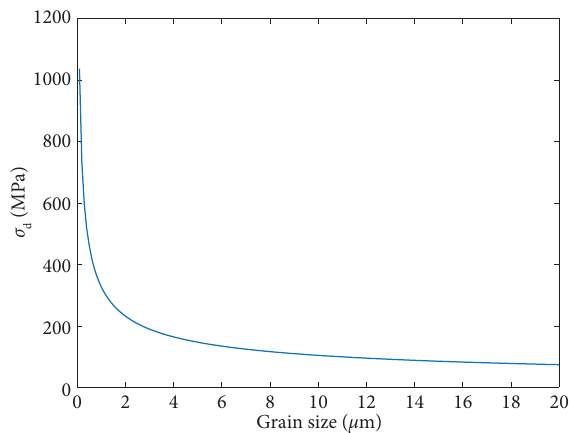
Figure 3: Te Hall–Petch relationship for the Ti6Al4V (ELI) alloy for diferent efective average grain